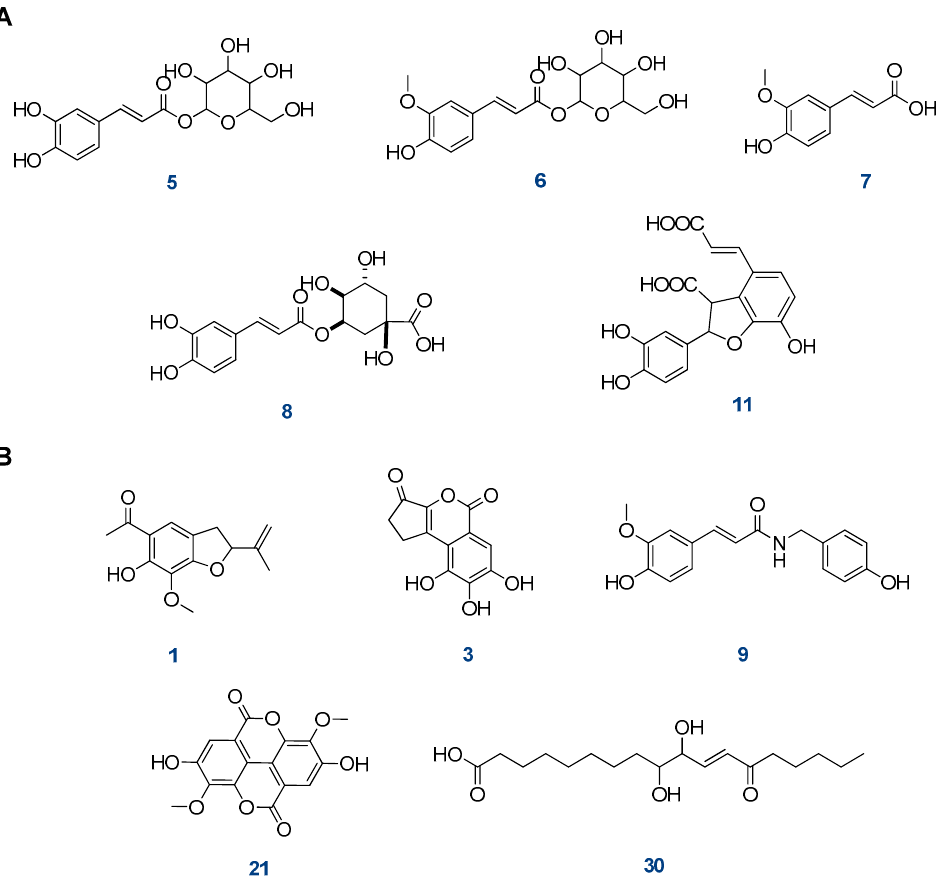
Figure 6. Chemical Structures of isolated compounds ( 1 – 4 ). 1